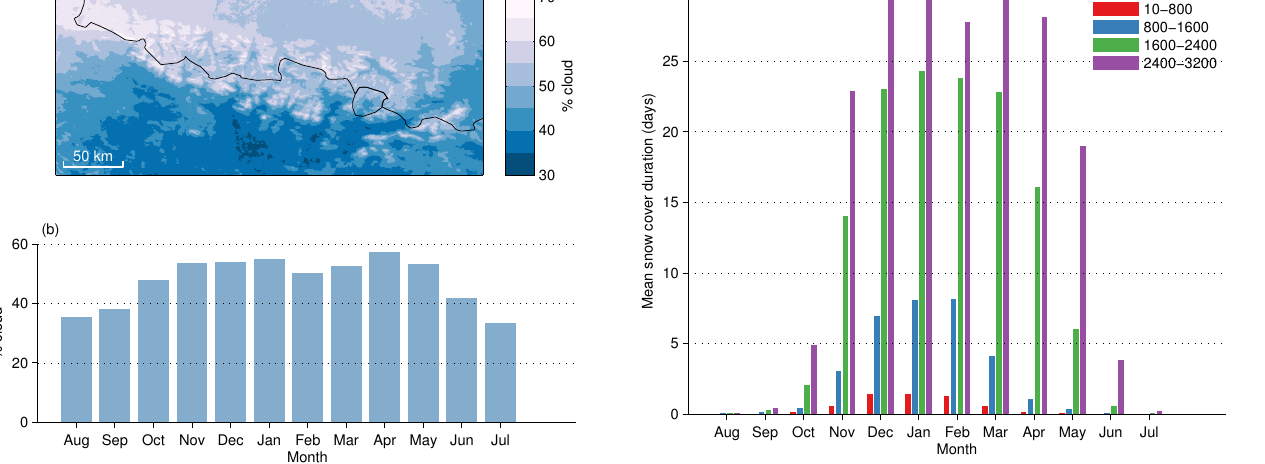
Figure 10. (a) Fraction of cloud-covered pixels in MOD10A1 over 2000–2013. (b) Mean monthly cloud coverage from MOD10A1 in the study area.